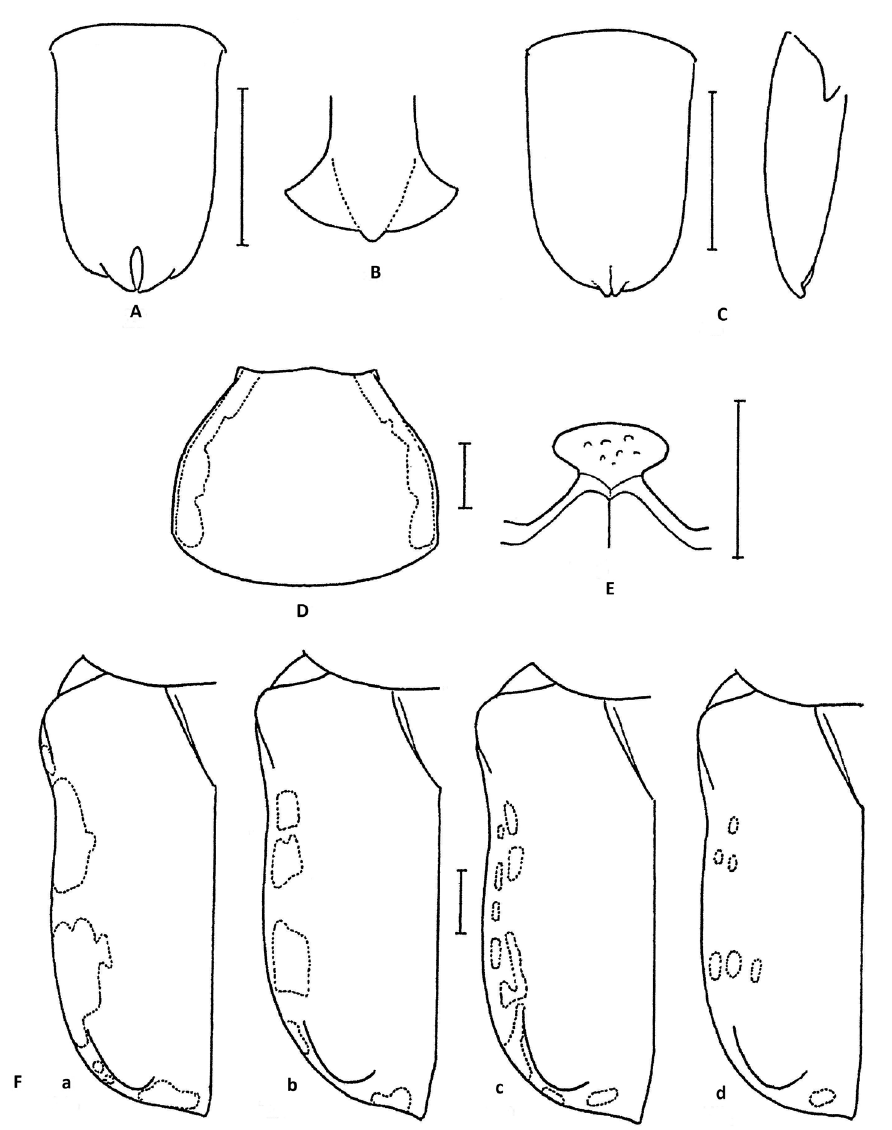
Figure 6. Atrichelaphinis ( Heterelaphinis ) sexualis : A parameres. Atrichelaphinis ( Heterelaphinis ) quadri- punctata : B apex of the parameres of the the lectotype. Atrichelaphinis ( Heterelaphinis ) nigra : C parameres D male pronotum E mesosternal lobe F left elytron ( a male; b–d female). Scale bar = 1 mm (From An- toine 2002: 187; permission obtained: 13 Feb